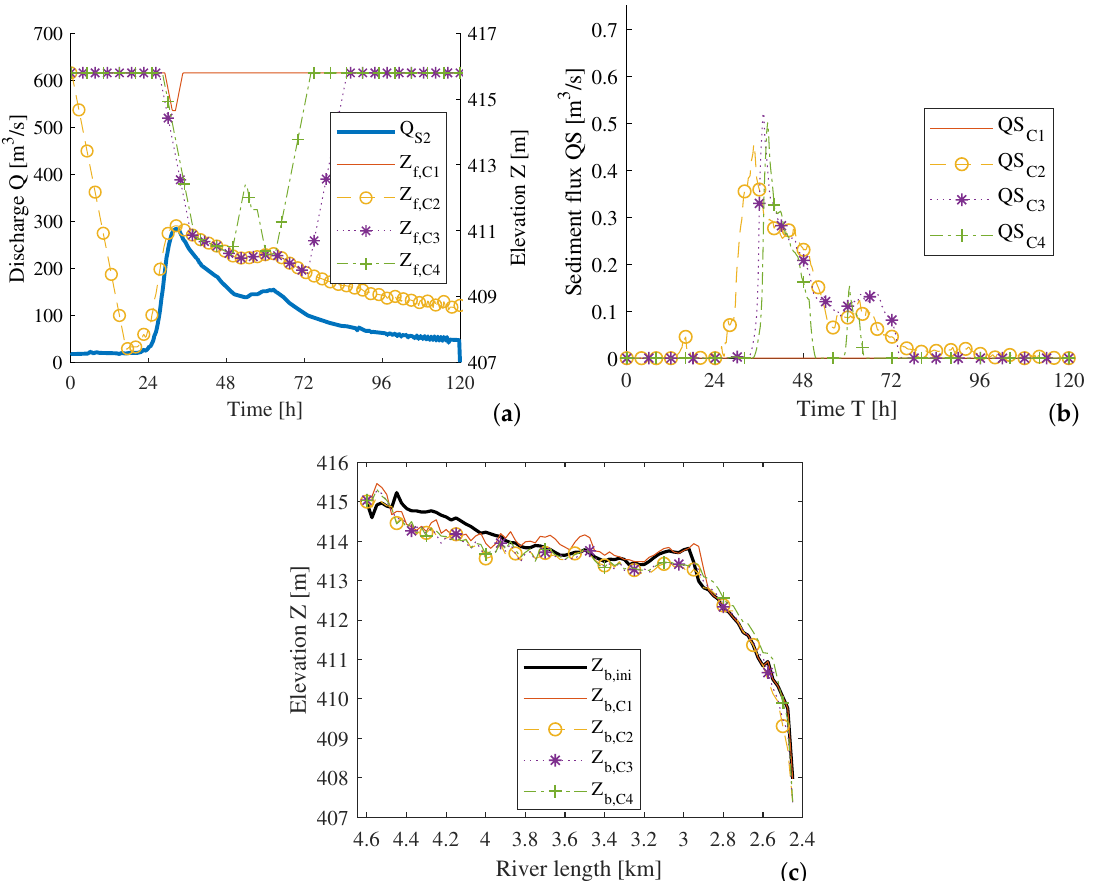
Figure 9. Medium flood scenario: ( a ) boundary conditions for the medium flood scenario and the four investigated regulation schemes; ( b ) simulated sediment flux at the outlet boundary for each case; and ( c ) longitudinal section of the mean riverbed in the reservoir for initial conditions (black) and the final situation for each